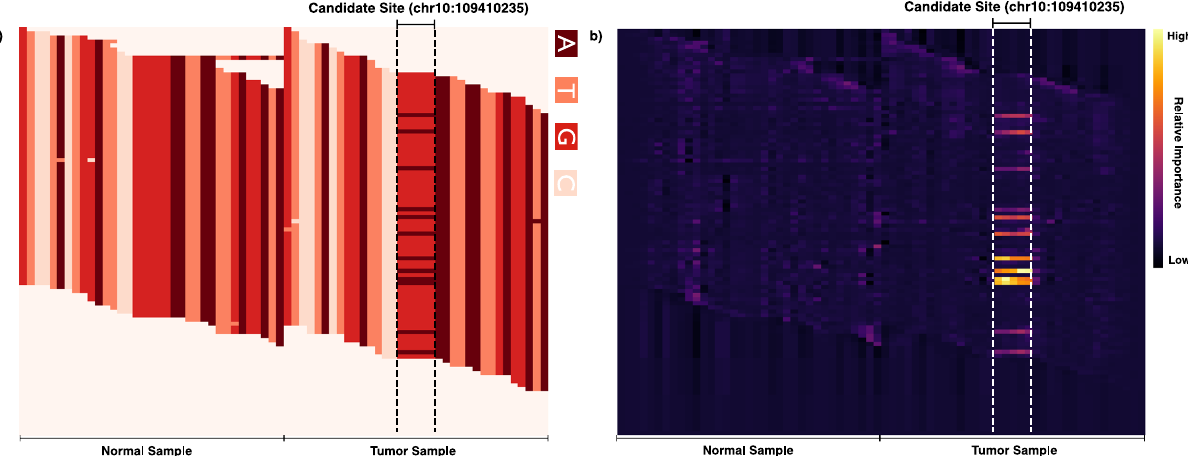
Fig. 5 Inference of model activation. a VarNet encoding (base channel) of an SNV on chromosome 10 in MBL. The candidate position is repeated 5× in both the normal and tumor image. Variant alleles are visible at the candidate site in the tumor sample image. b Heatmap visualization showing ‘ pixels ’ in the base channel most important to VarNet ’ s deep learning model. VarNet has identi fi ed variant alleles at the candidate site in the tumor. Pixel-wise importance scores were computed using Guided